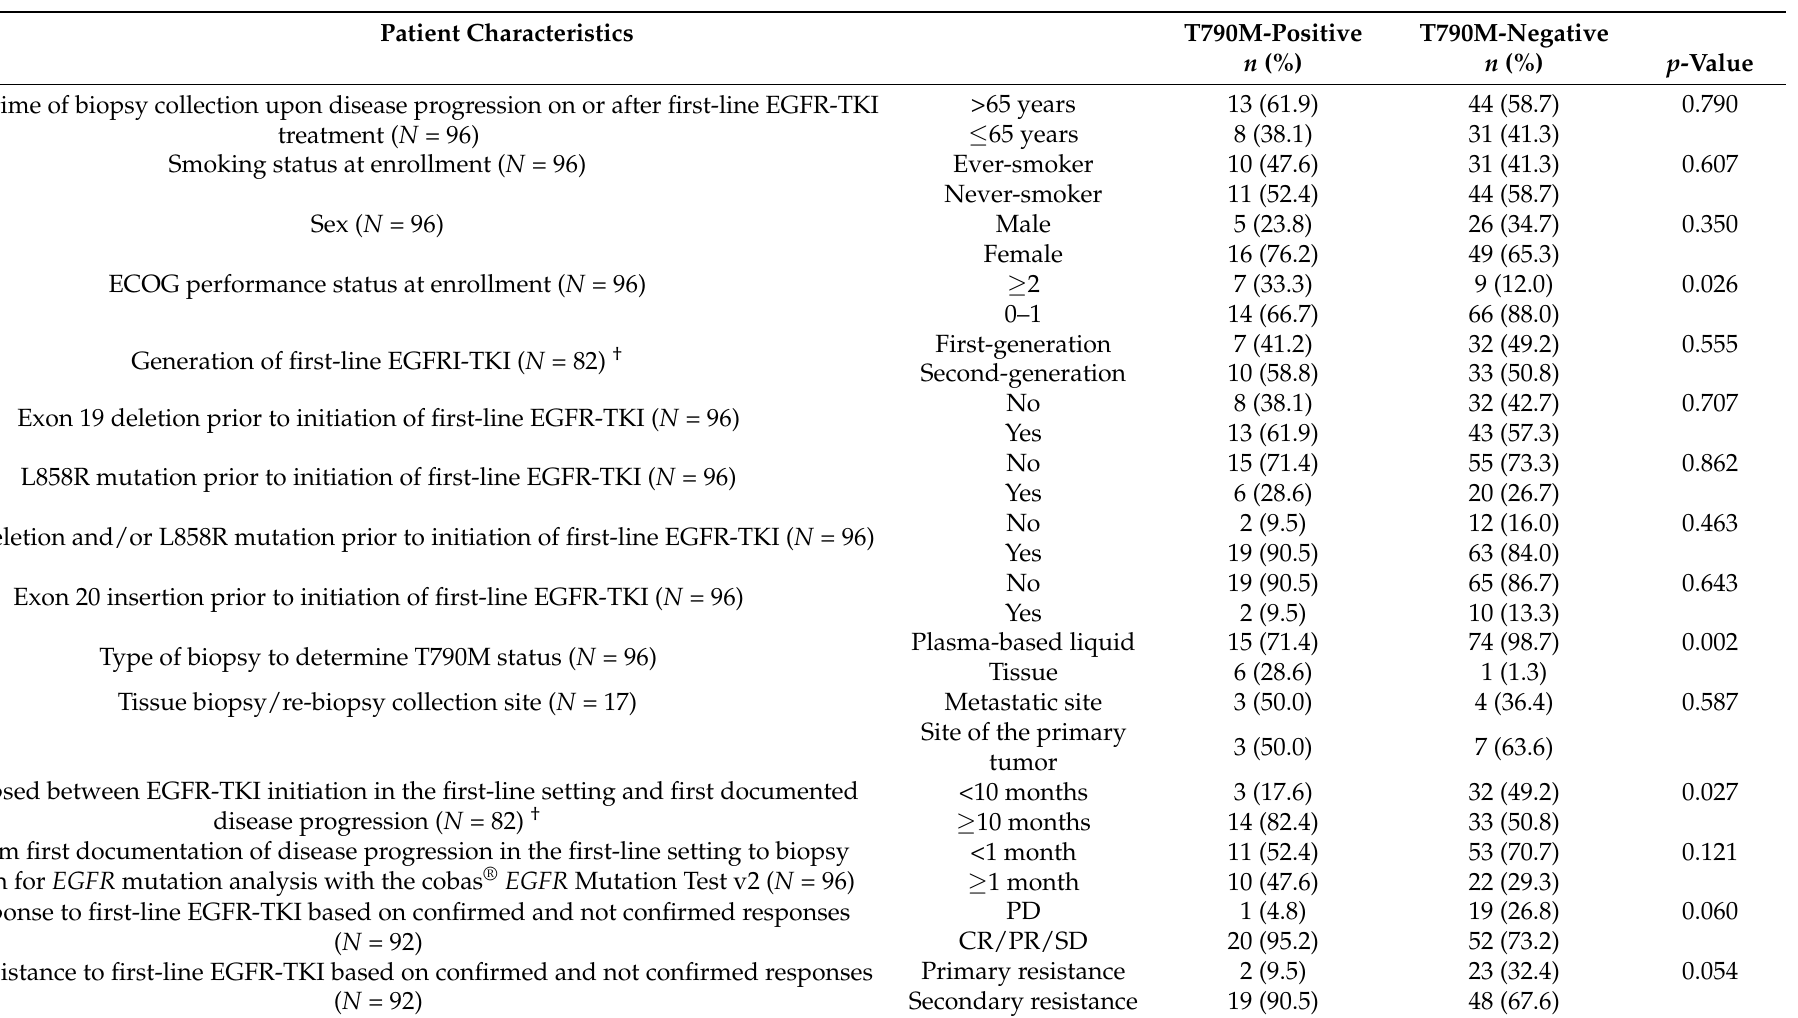
Table 5. Patient and clinicopathological characteristics according to the T790M mutation